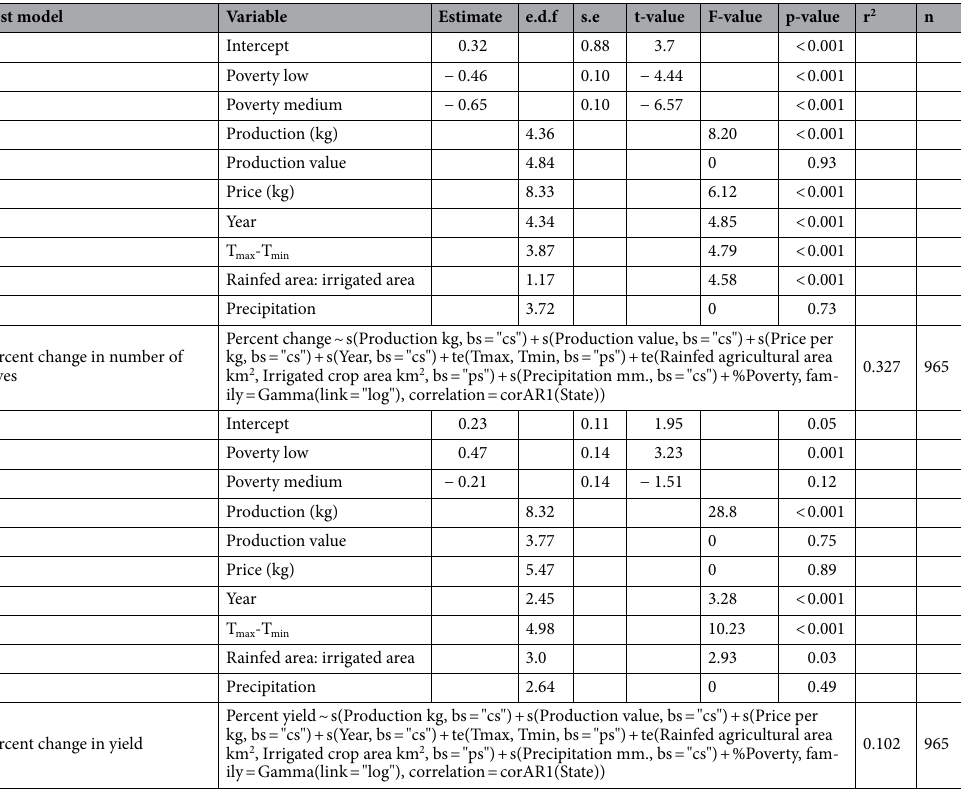
Table 1. The GAMM analysis results for percent change in yield, and percent change in the number of honey bee hives, including covariates for each model. e.d.f estimated degrees of freedom, s.e standard error.